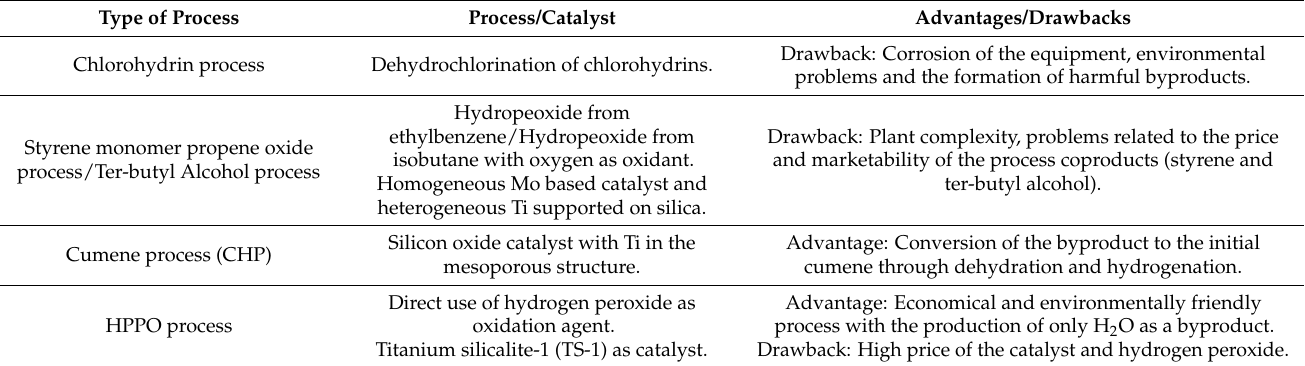
Table 2. Main processes for the propylene oxide Table 2 . Main processes for the propylene oxide synthesis.